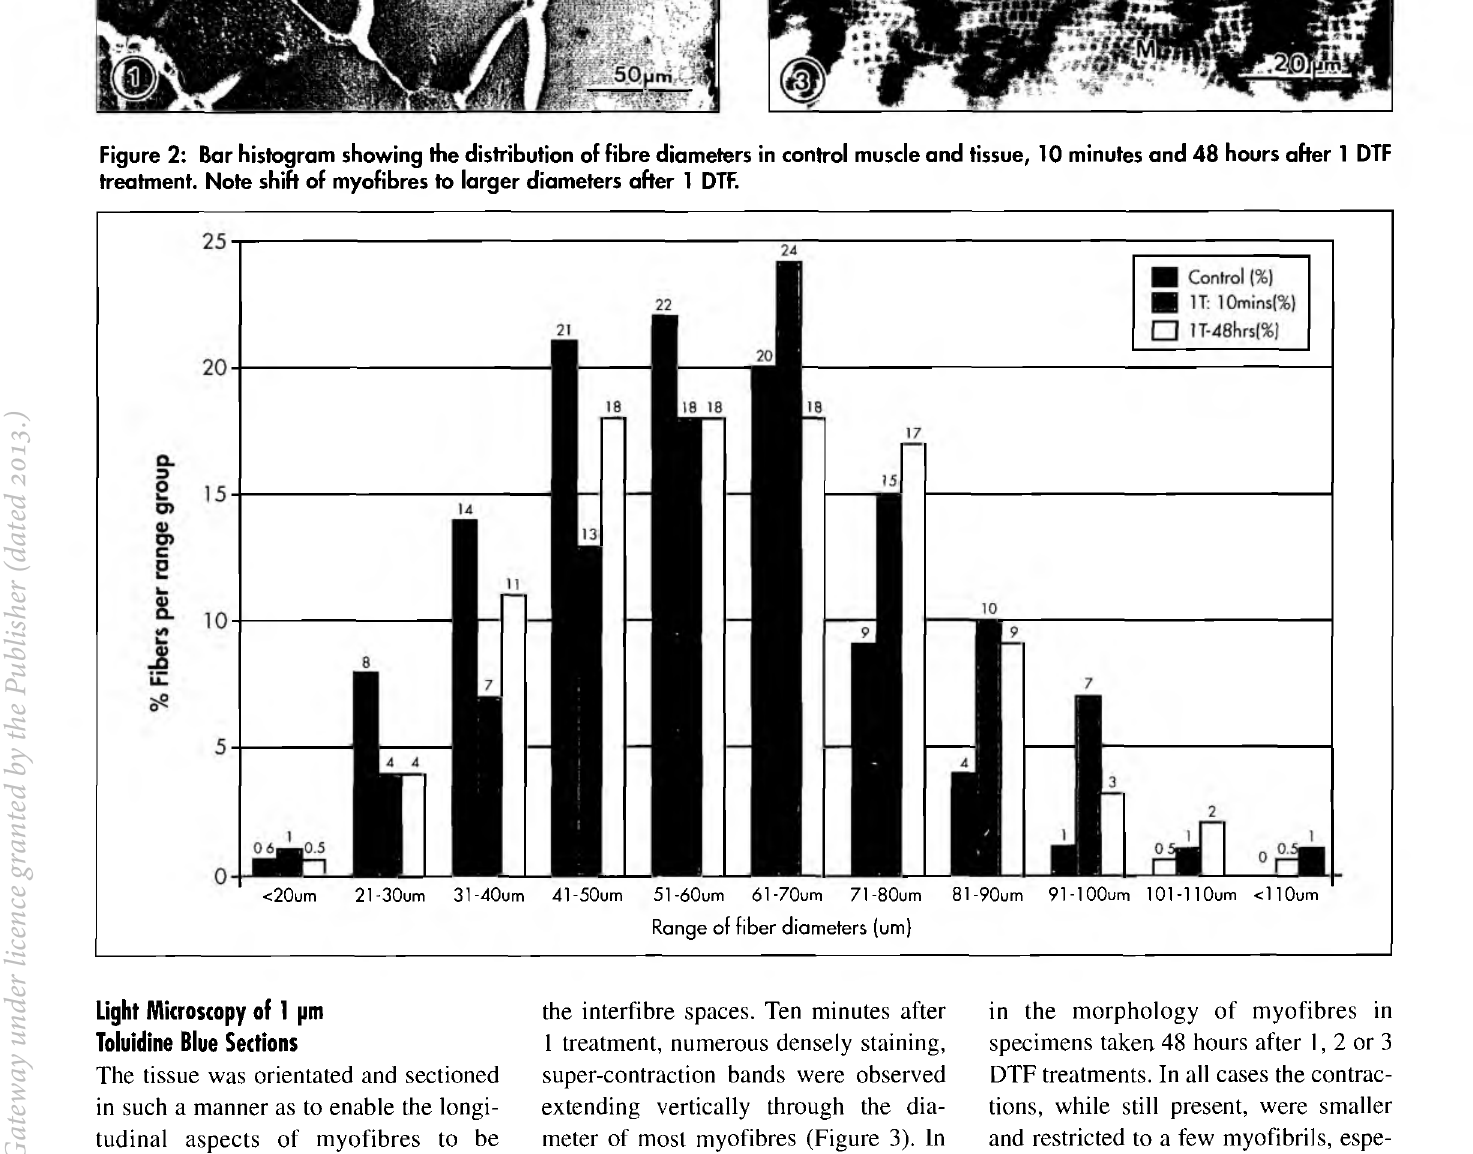
Figure 1: Light micrograph of 5 pm wax embedded, haema- toxylin and eosin stained section showing cross-sectioned myofibres (F) in normal rabbit skeletal muscle. The arrows mark the diameters of fibres used for morphometry.